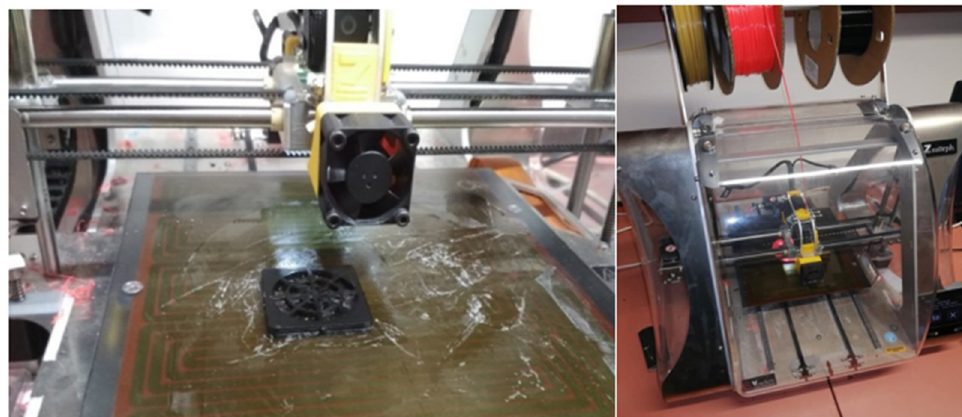
Figure 10. A more detailed shot of 3D printing on the ZMorph printer.